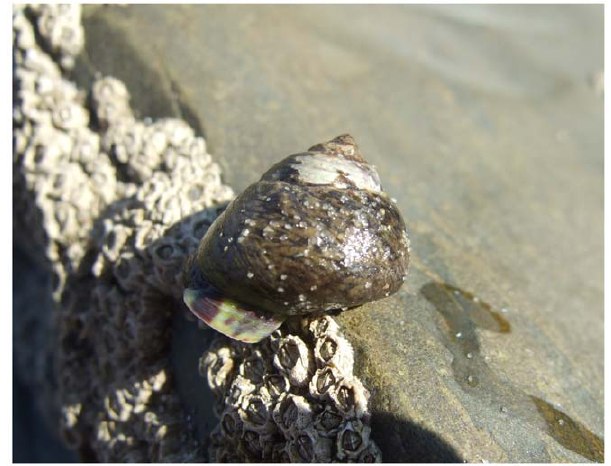
Figure 2. Photograph of an Osilinuslineatus individual (unde- termined gender) taken at Homem de Leme, Porto, Portugal.